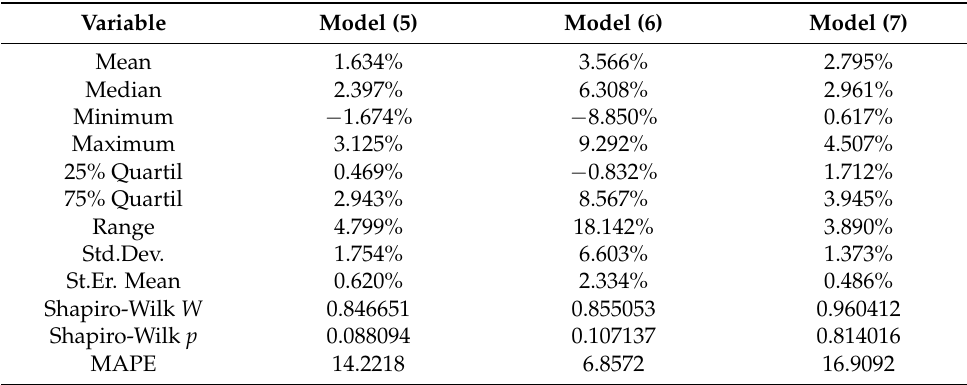
Table 4. Basic characteristics of the suitability of selected